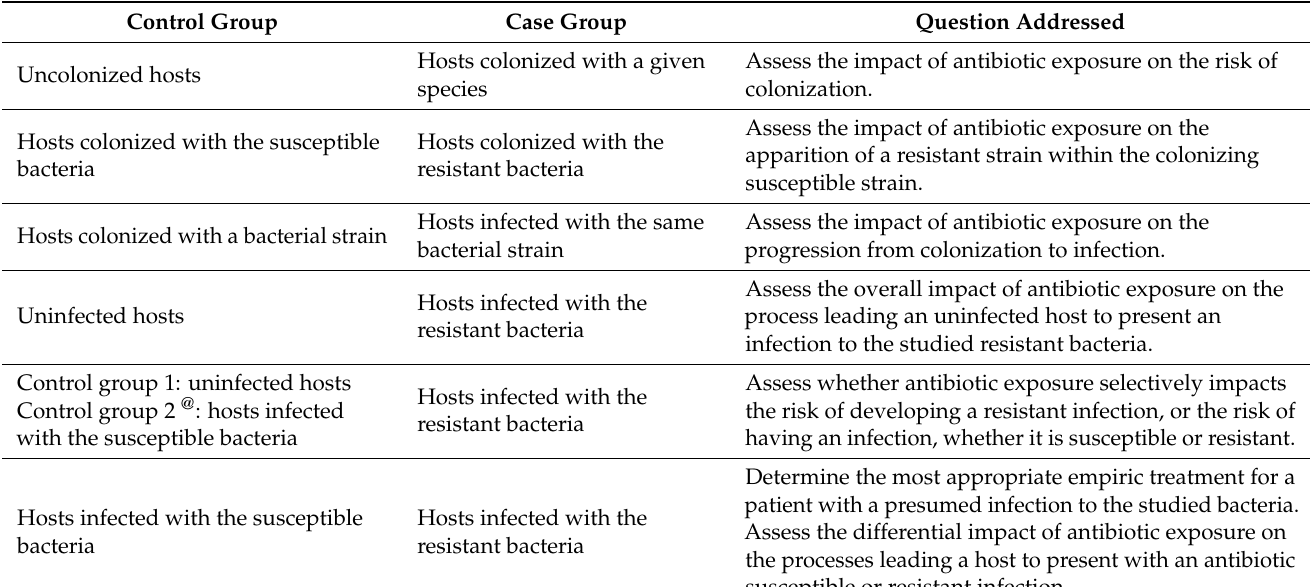
Table 2. Selecting the case and control groups according to the specific